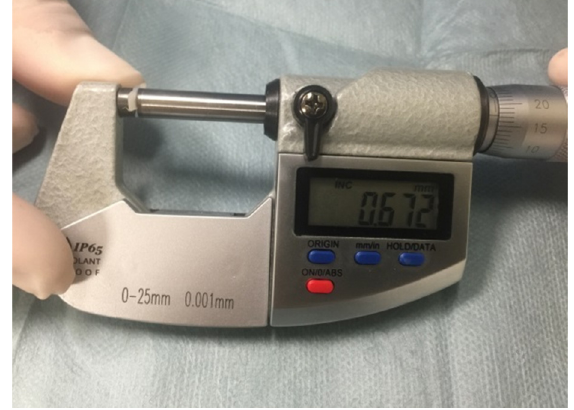
Figure 1 Measurement of the thickness of tragal cartilage using a